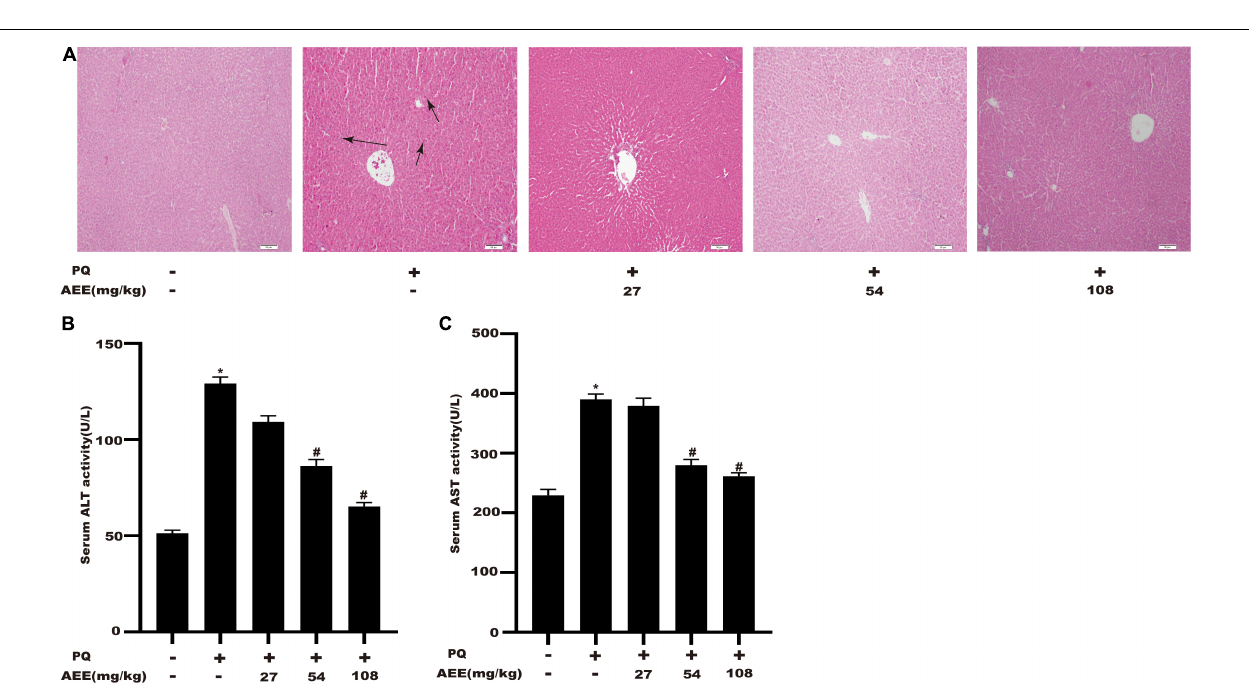
FIGURE 5 | AEE reduces PQ-induced liver injury in rats. (A) Representative images of the morphological observations of histopathological changes. Scale bar: 100 µ m. Note: The arrows of the pathological sections represent the cell atrophy and hyperemia. (B) The level of ALT in rat serum was measured in different treatment groups. (C) The level of AST in rat serum was measured in different treatment groups. Values are presented as the means ± SD where applicable ( n = 6). * p < 0.05 compared with the control group; # p < 0.05 compared with the PQ